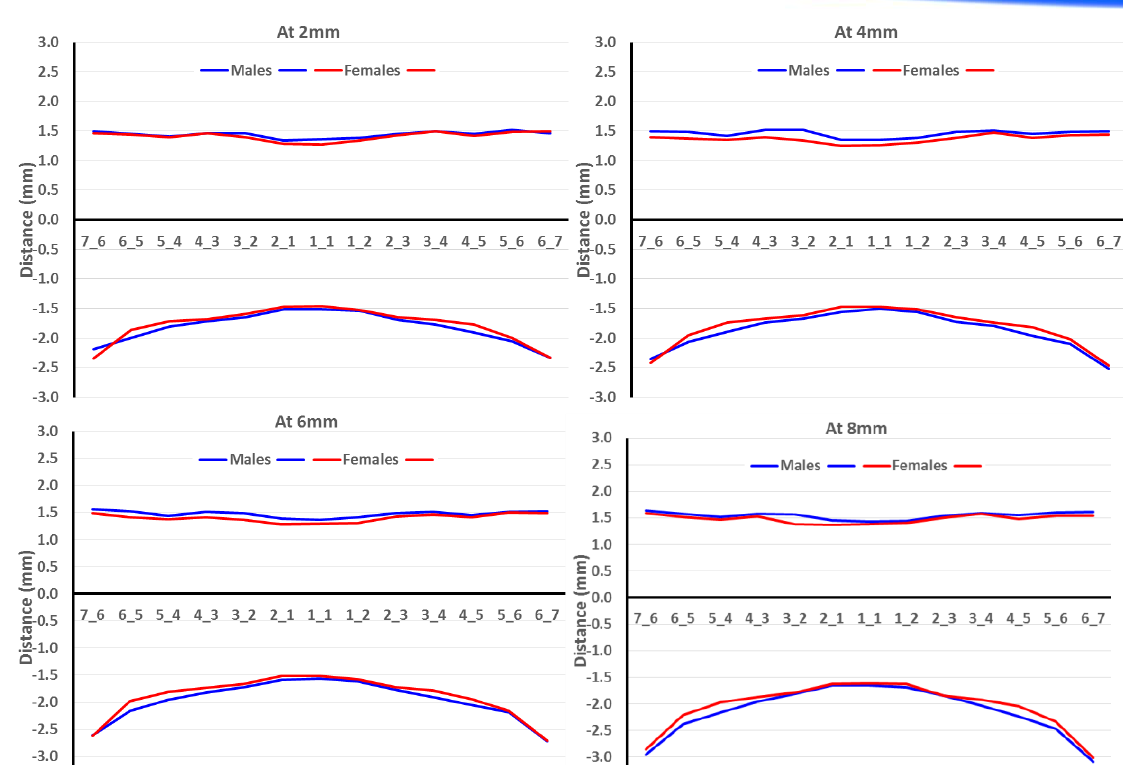
Figure 1: The buccal cortical bone thickness of the maxilla and mandible for males and females at 2, 4, 6 and 8mm from the alveolar crest.